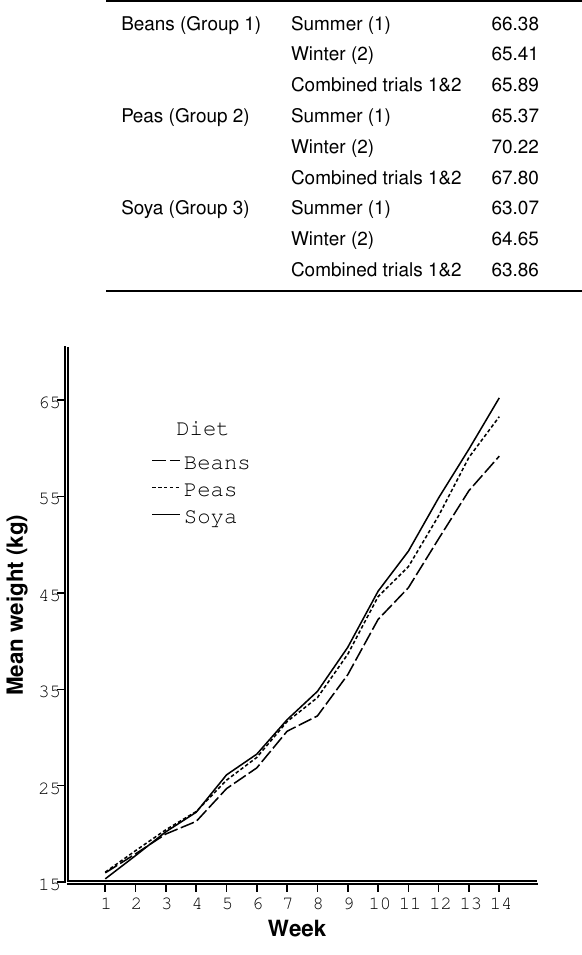
Figure 1. Growth curves depicting the mean pen weights of pigs, consisting of the pen means of both the summer and winter trials, on the control and treatment diets during the 13 week trial